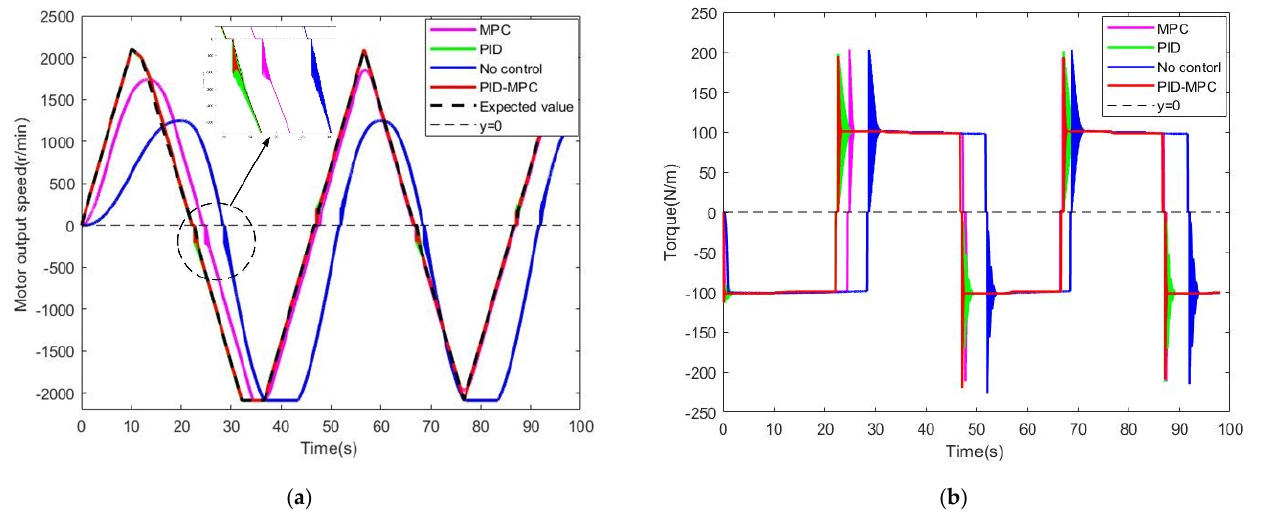
Figure 14. Speed and Torque control effect diagram at variable displacement ratio. ( a ) motor output speed; ( b ) motor output torque.